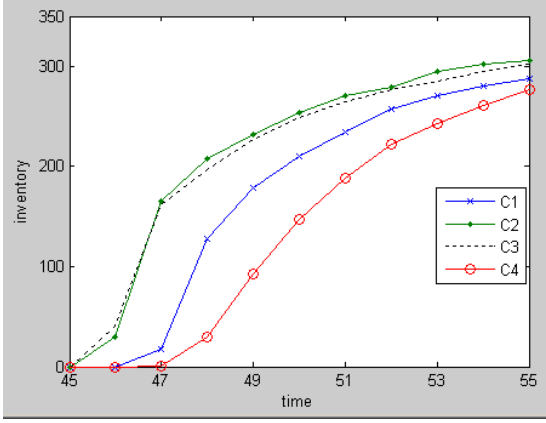
Figure 6. Inventory level in different UHD over